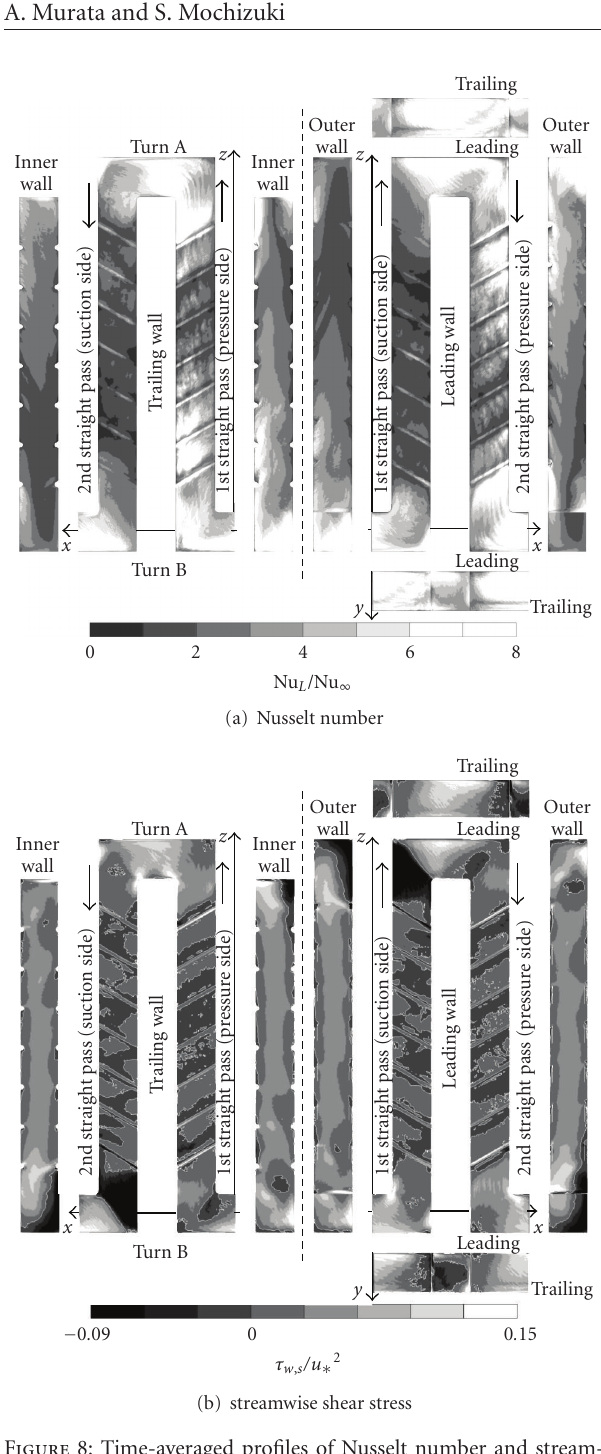
Figure 8: Time-averaged profiles of Nusselt number and stream- wise component of wall shear stress (60 ◦ rib NP, Re ∗ = 4000, Ro ∗ = 2, and Ra ∗ = 0).